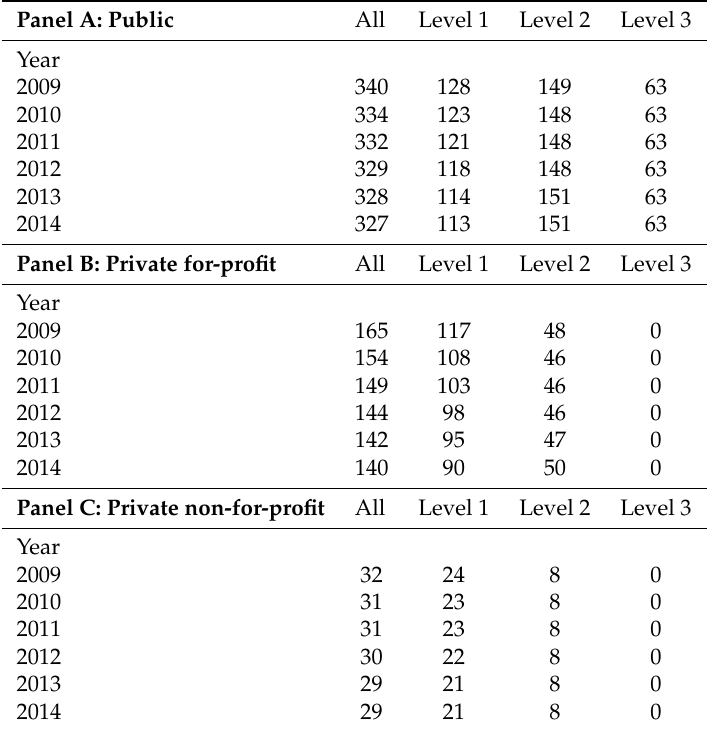
Table 2. Number of public and private maternity units